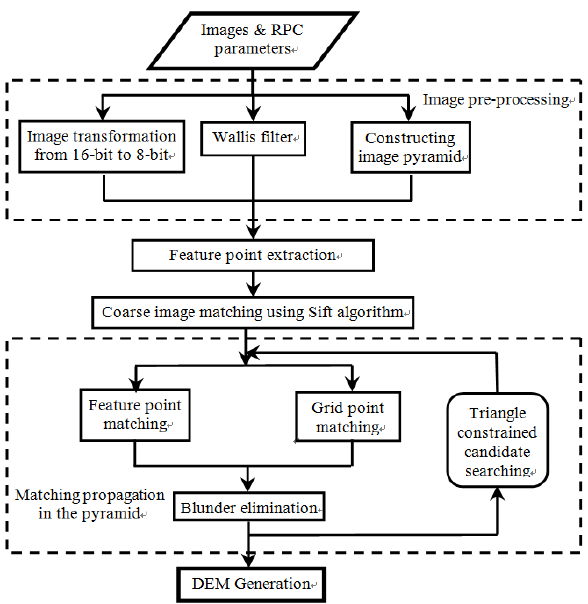
Figure 1. Workflow of our image matching